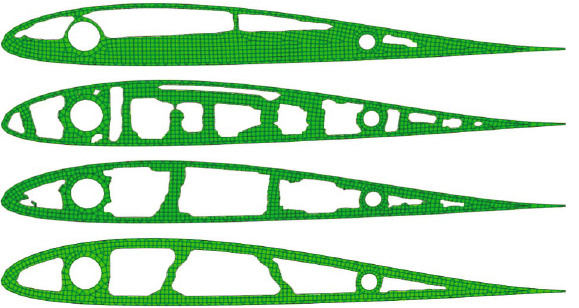
Figure 16: Wing rib optimization history.